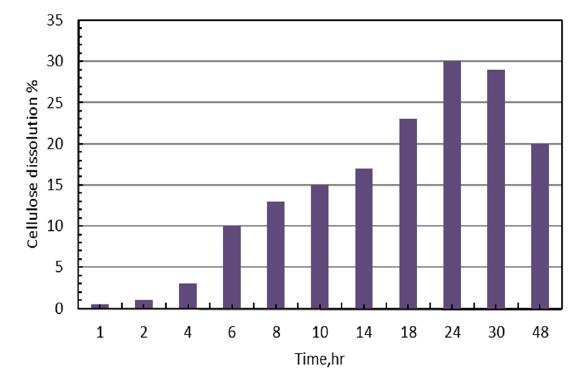
Fig. 4. Effect of Fenton's reagent duration on cellulose